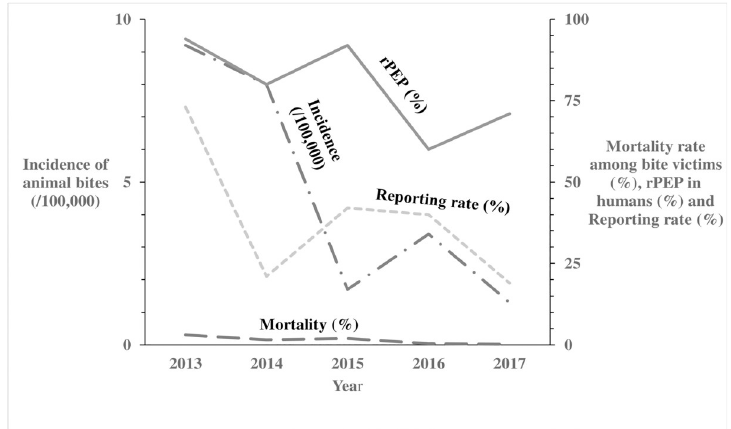
Fig 1. Trends of incidence of animal bites, anti-rabies vaccinations in humans, corresponding mortality rates and reporting rates in Uganda: 2013–2017. The Long Dash Dot line represents the incidence of animal bites (/100,000) in humans. The Solid line represents the anti-rabies vaccinations in humans. The Long Dash line represents the mortality rates in humans following a bite from a suspected rabid animal. The Square Dot line represents the reporting rates per